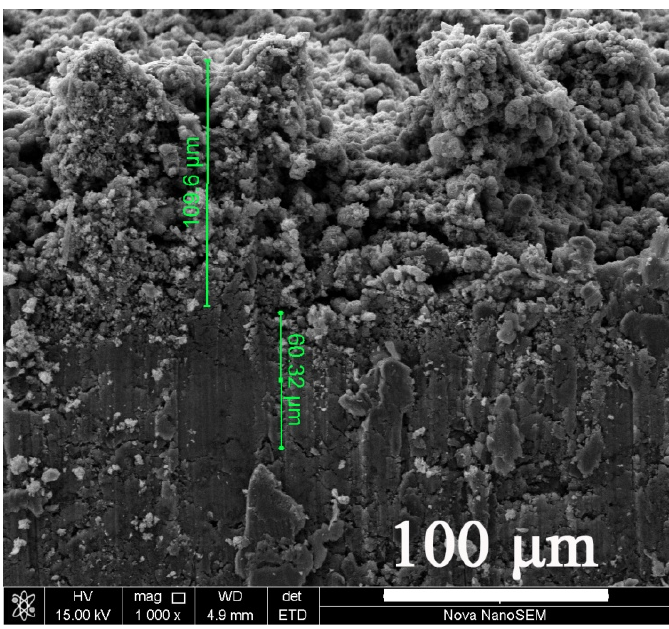
Figure 9. SEM cross-sectional image of a superhydrophobic sample.